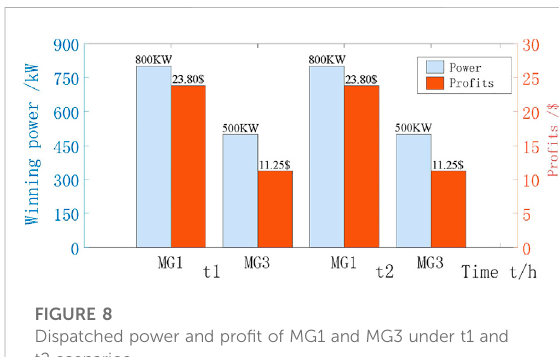
FIGURE 8 Dispatched power and pro fi t of MG1 and MG3 under t1 and t2 scenarios.